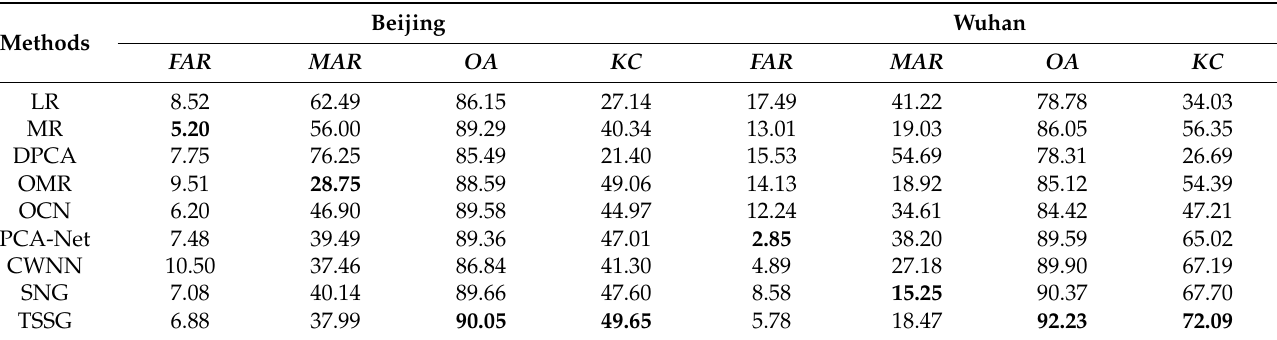
Table 4. Quantitative accuracy results for different methods on SAR data sets (The best ones are shown by